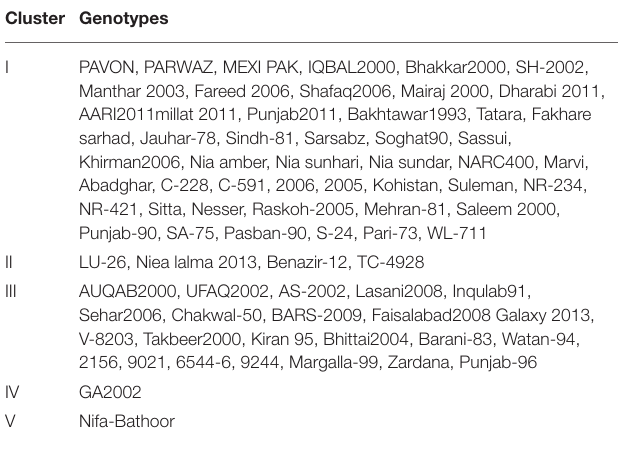
TABLE 3 | Distribution of wheat genotypes regarding single kernel characteristics in different clusters. Cluster Genotypes